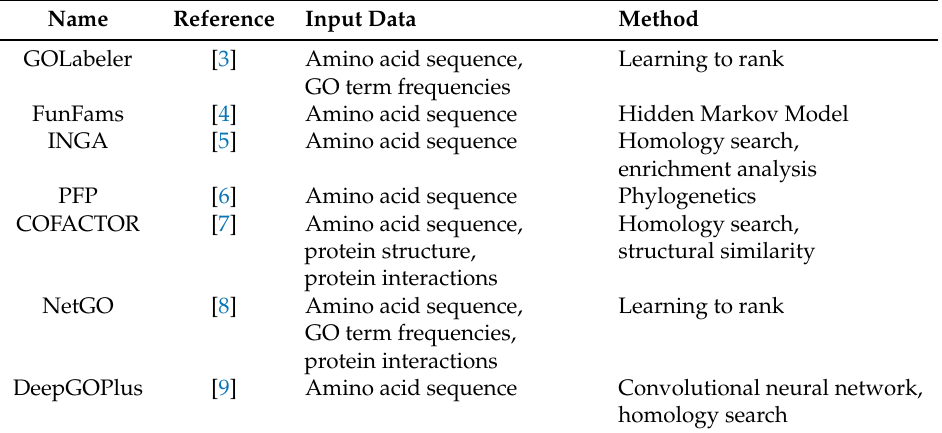
AFP: Automatic Function Prediction. GO: Gene